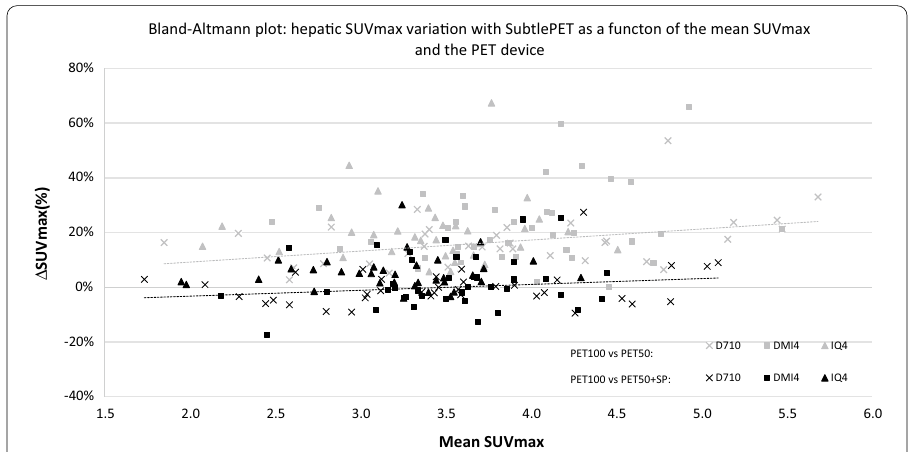
Fig. 7 Bland Altman plot of the hepatic SUV max variation (%) as a function of mean SUV max between the 2 PET series, for the 110 patients. The cross, squares and triangles represent the data from the 3 PET devices (D710, DMI4 and IQ4